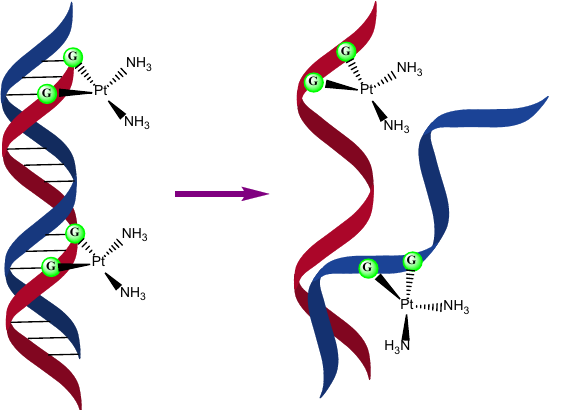
Figure 2. Interaction of the compound cisplatin with DNA through guanines ( left ) and its denaturalization ( right ).